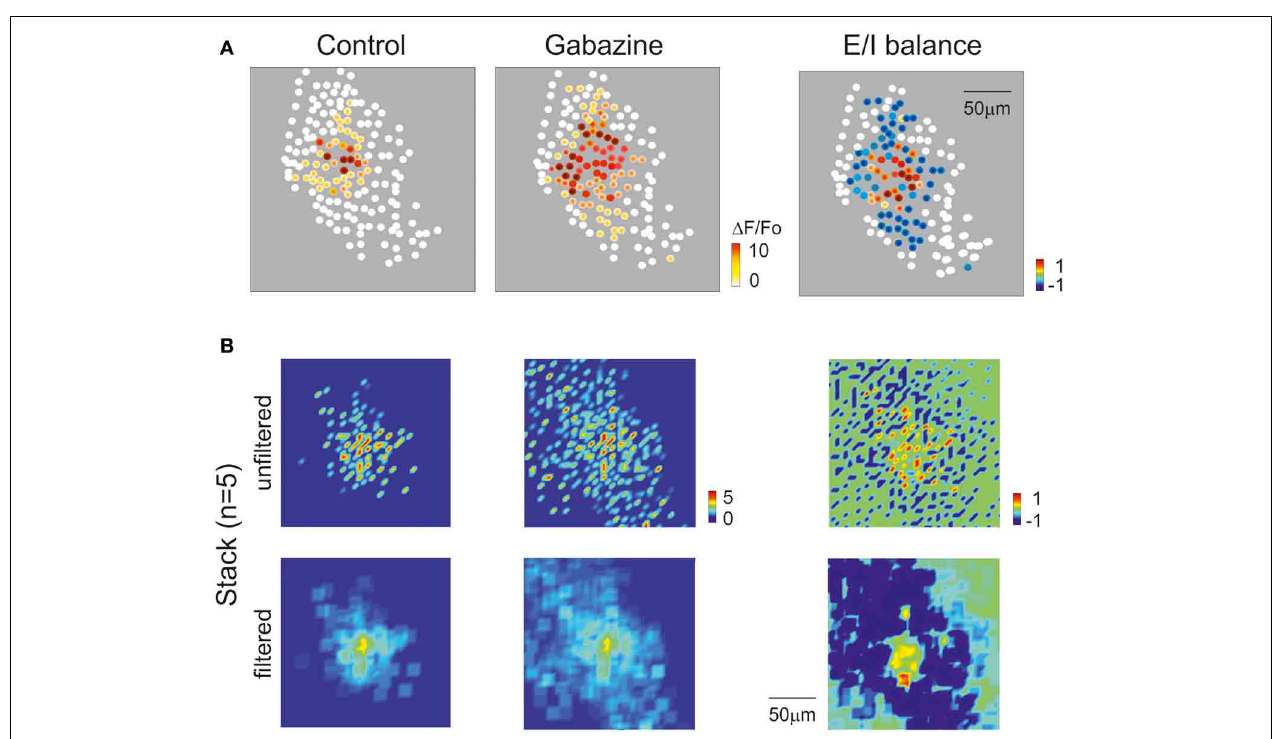
FIGURE 10 | Cerebellar circuit responses IV: reconstruction of center-surround structure. (A) Activity maps of the granular layer with 20 × magnification showing the peak intensity of neuronal responses on a color scale. The location of colored dots corresponds to that of neurons in the slice. The left most and mid panels show that the activation intensity, number of active cells and extension of activated area increase remarkably by applying gabazine. The E/I balance plot on